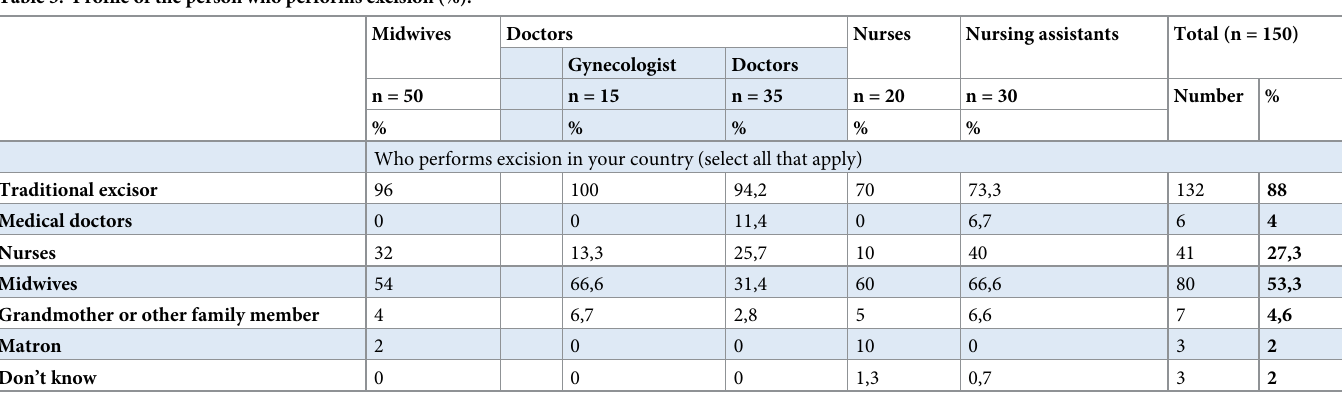
Table 5. Profile of the person who performs excision